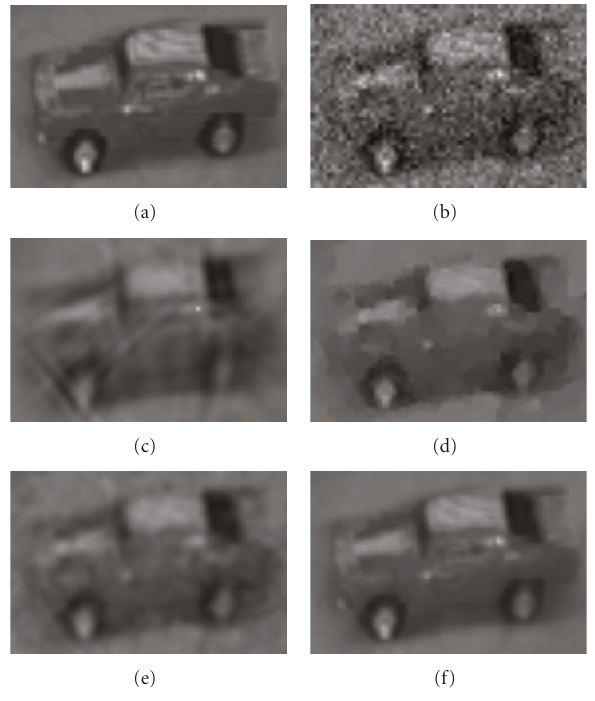
L 2 ( Ω ); ∇ u ∈ L 2 ( Ω ) × L 2 ( Ω ) } . The problem of inf( E ( u ), u